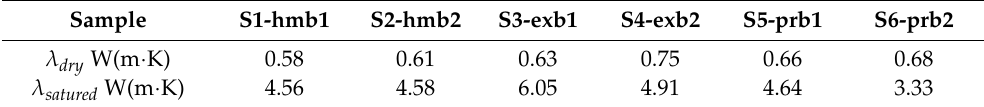
Table 6. Dry and saturated conductivity of the test samples, estimated according to EN 1745 [26].